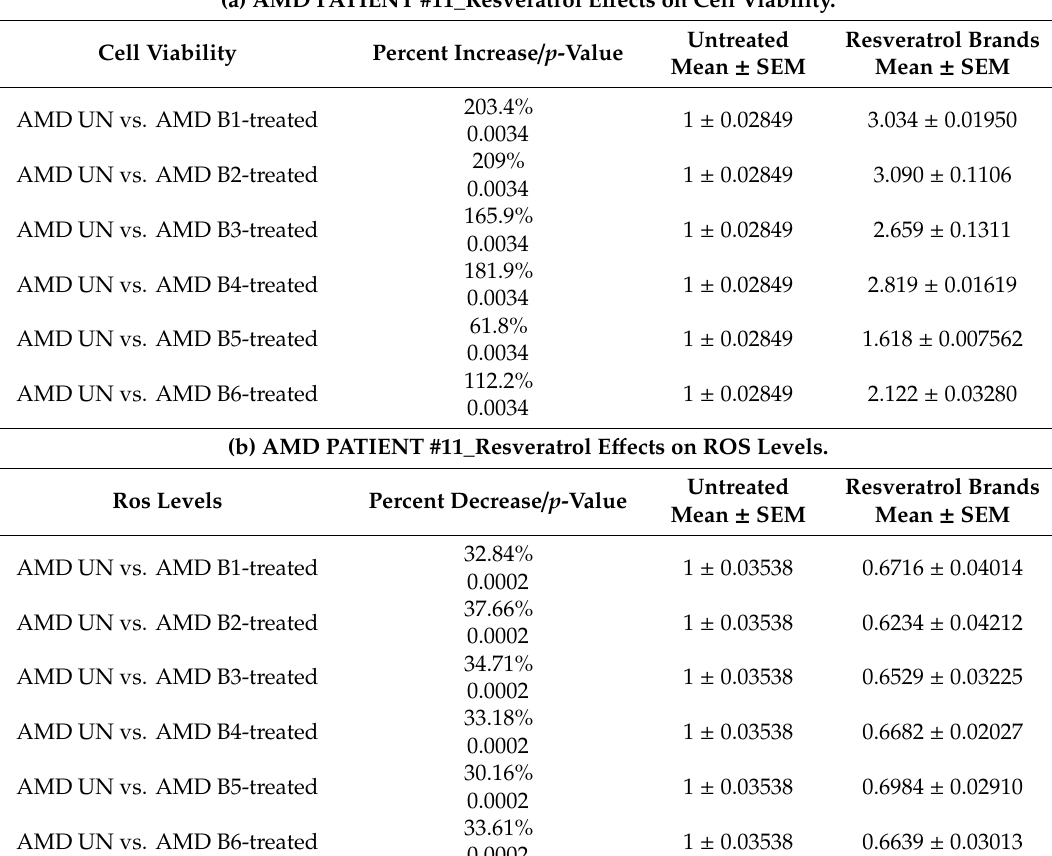
Table 13. E ff ects of resveratrol formulations on cell viability ( a ) and ROS levels ( b ) in AMD patient # 11. (a) AMD PATIENT #11_Resveratrol E ff ects on Cell